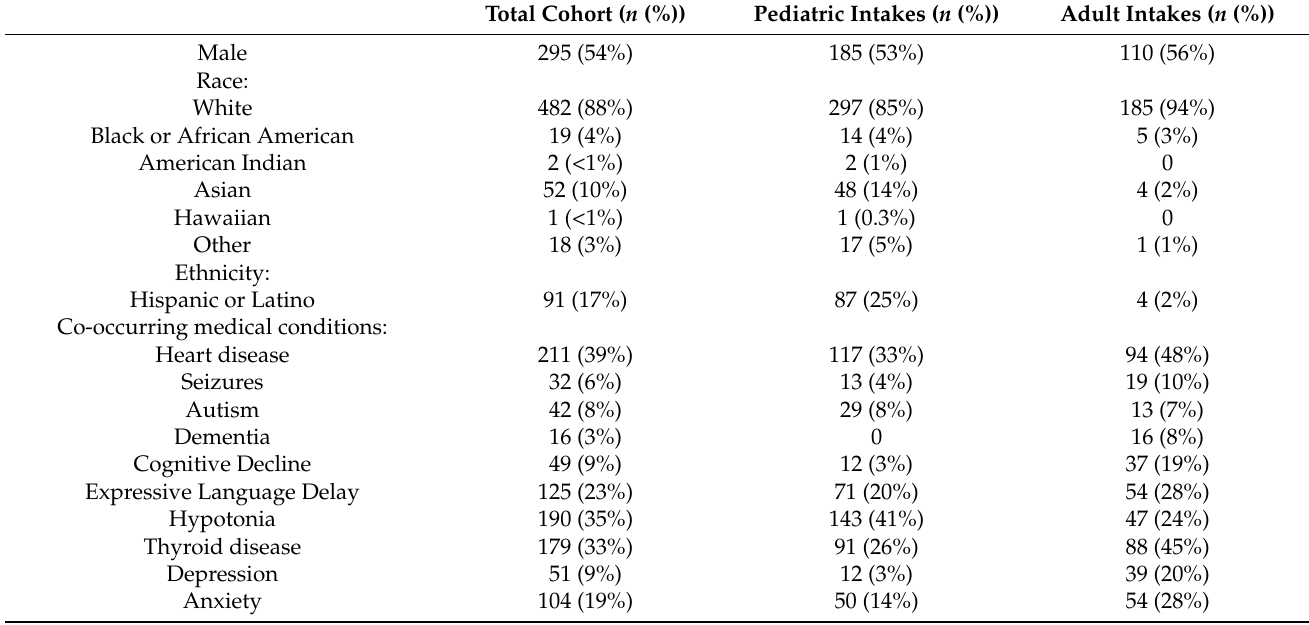
Table 1. Demographic details of the 546 patients with Down syndrome (DS) in the Massachusetts General Hospital Down Syndrome Program (MGH DSP) with completed electronic intake